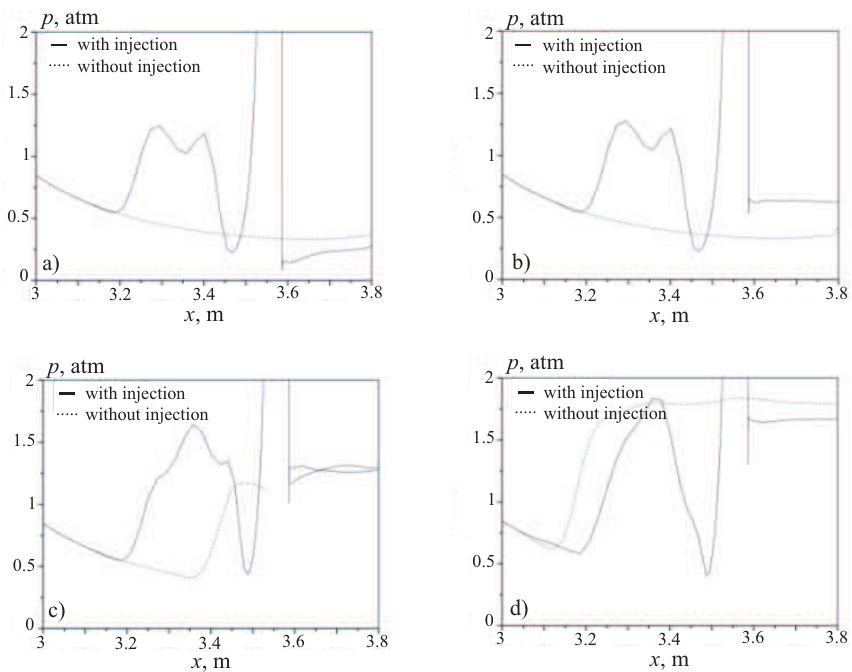
Figure 16. Distributions of static pressure for: n = 0.4, p n = 0.5 atm ( a ); n = 0.2, p n = 1.0 atm ( b ); n = 0.2, p n = 1.5 atm ( c ); n = 0.1, p n = 2.0 atm ( d